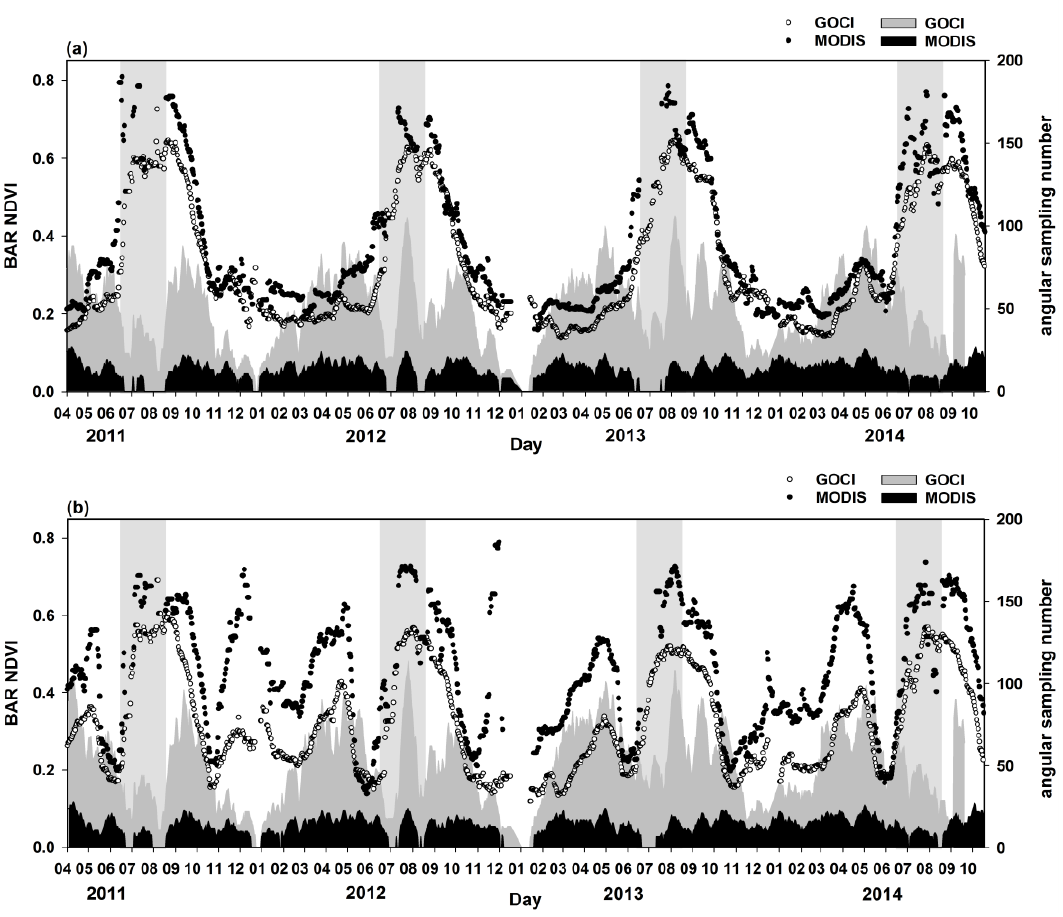
Figure 3. Year-to-year variation in crop seasonal dynamics using GOCI- and MODIS-based vegetation indices. The open and solid circles show the GOCI BAR NDVI and MODIS NBAR NDVI, respectively. The gray and black histograms show the number of GOCI and MODIS angular samples, respectively. ( a ) Intermediate-late-maturing rice paddy, and ( b ) Early maturing rice paddy. The four light gray areas from middle June to middle August are rainy summer seasons in South